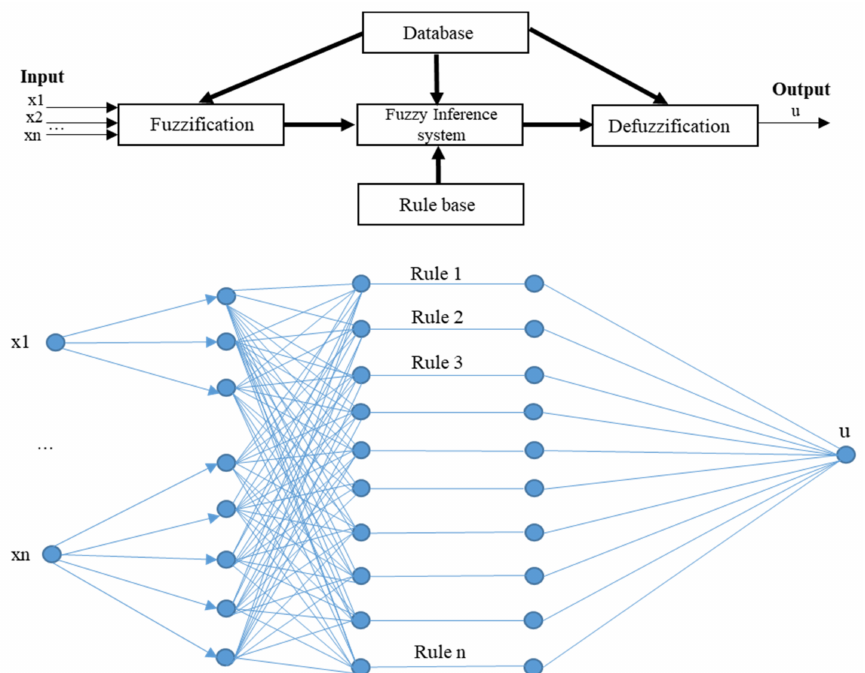
Figure 6. The basic structure of fuzzy control system.